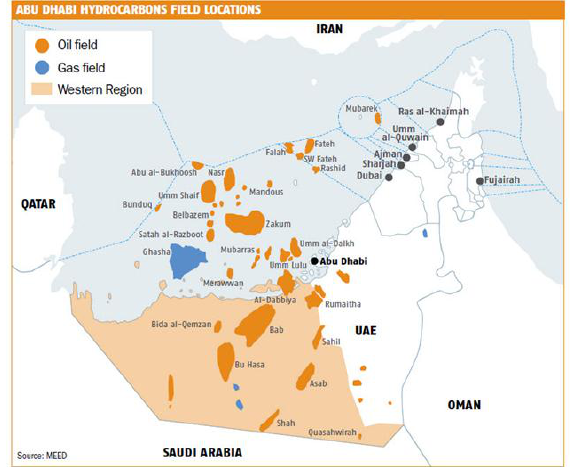
Figure 3: Oil and gas fields in UAE (source: Watts 2013)